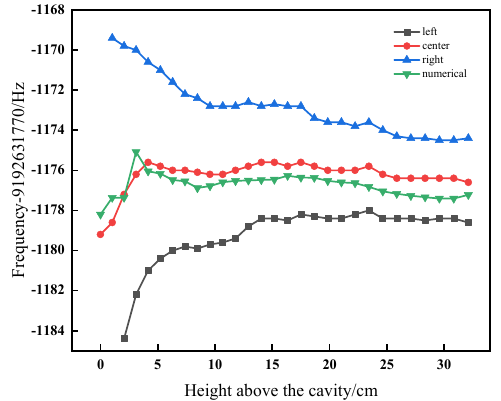
Figure 8. Measured three fringes and the calculated central fringe for ( − 1, − 1) magnetically sensitive Ramsey transition as a function of apogee height above the Ramsey cavity.